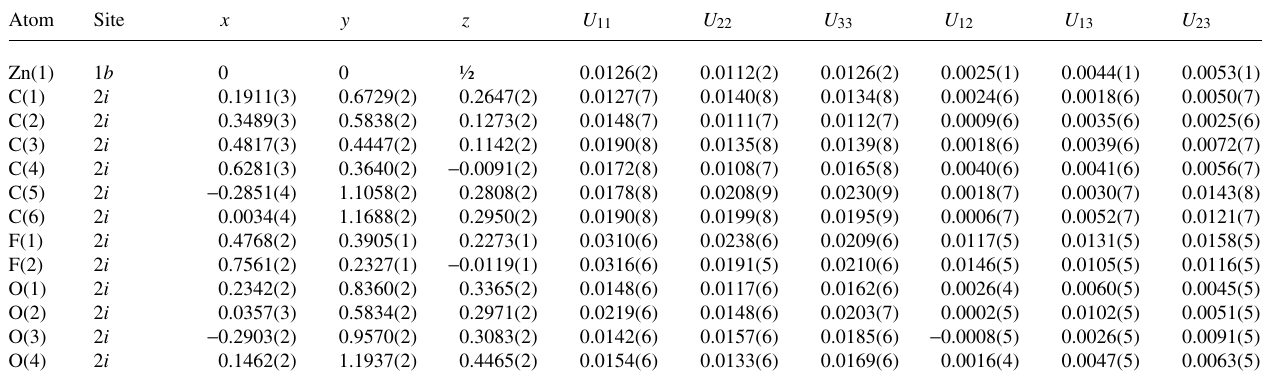
Table 3. Atomic coordinates and displacement parameters (in Å 2 ) .